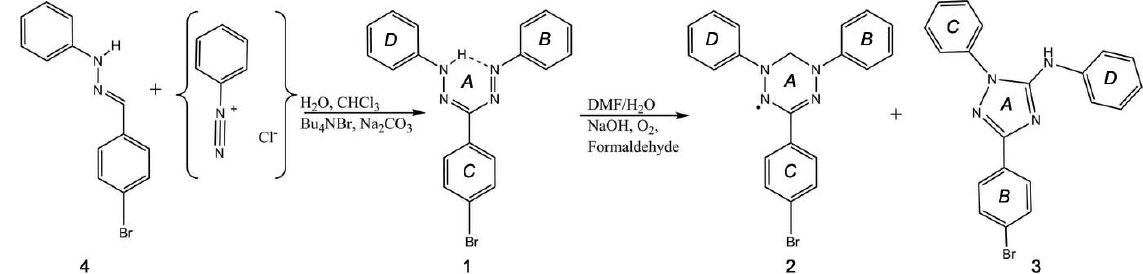
Figure 5 Synthesis of 1 , 2 , and 3